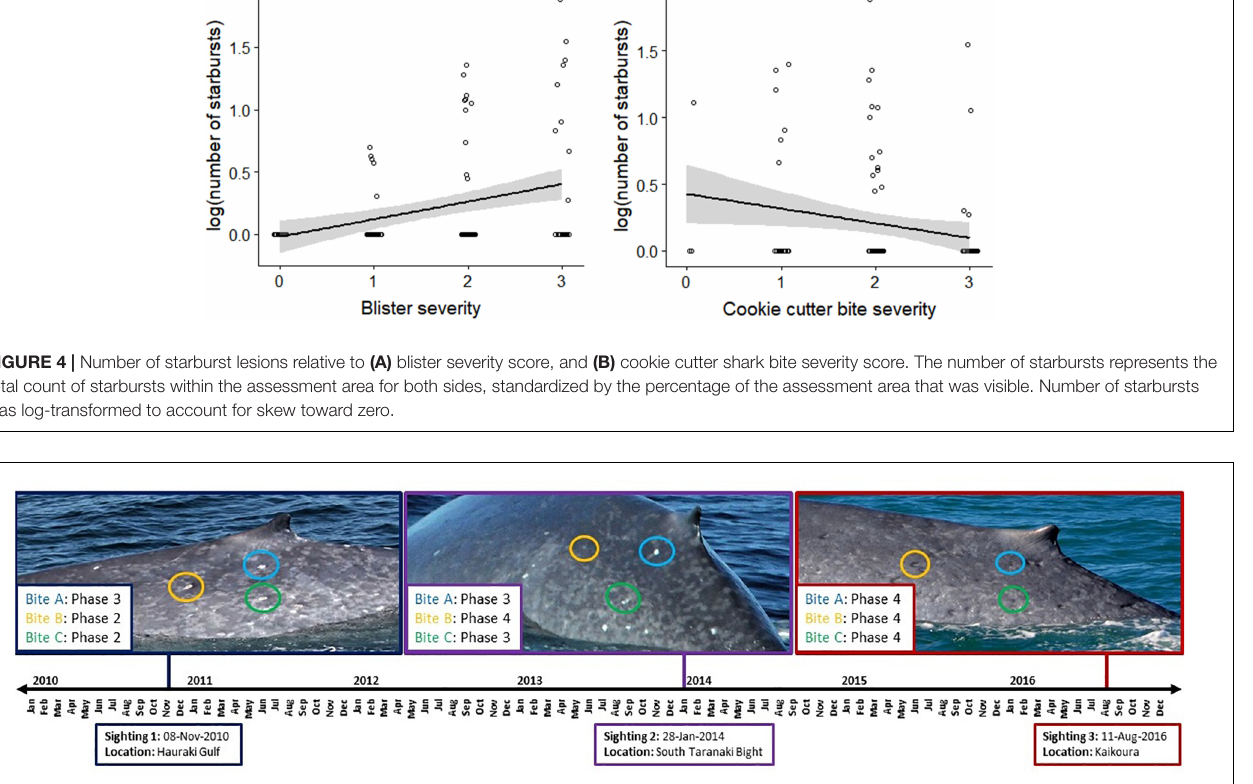
FIGURE 5 | Timeline for cookie cutter shark bite healing for one individual blue whale that was re-sighted three times over a 7-year period. Example bites are circled in each image, where corresponding color denotes the same marking at each sighting over